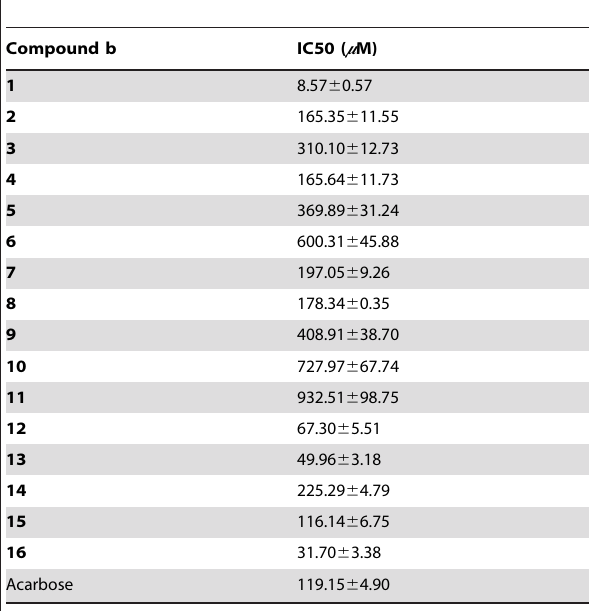
Table 5. DPPH Radical-scavenging and Superoxide anion Radical-scavenging Activities of The Isolated Compounds 1–